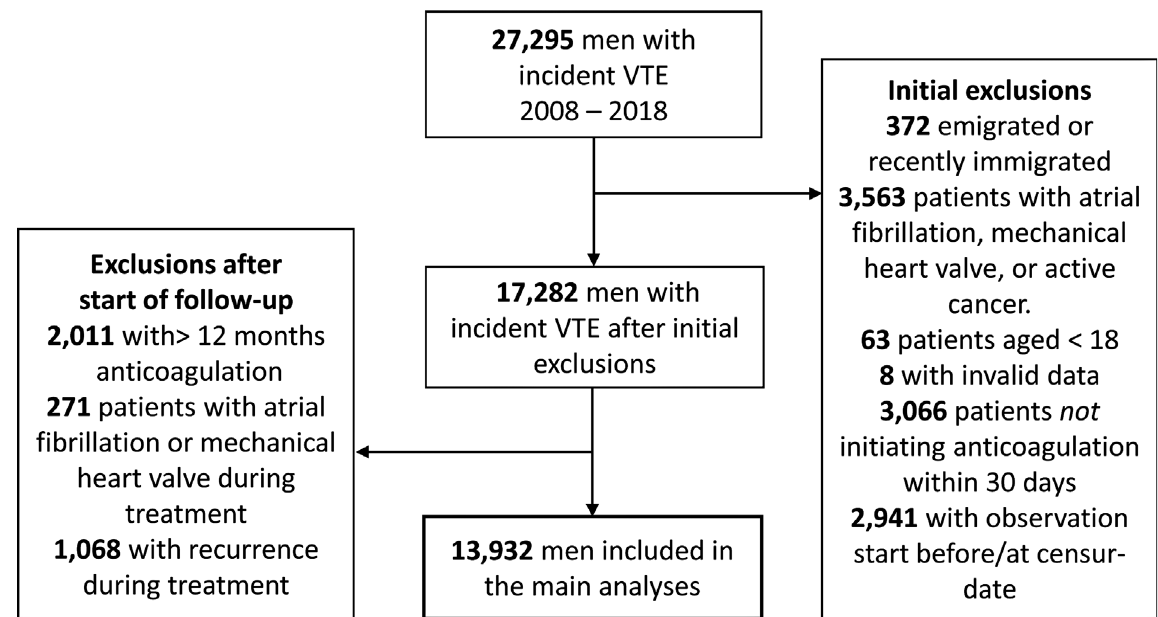
Fig. 1 Flowchart of the study